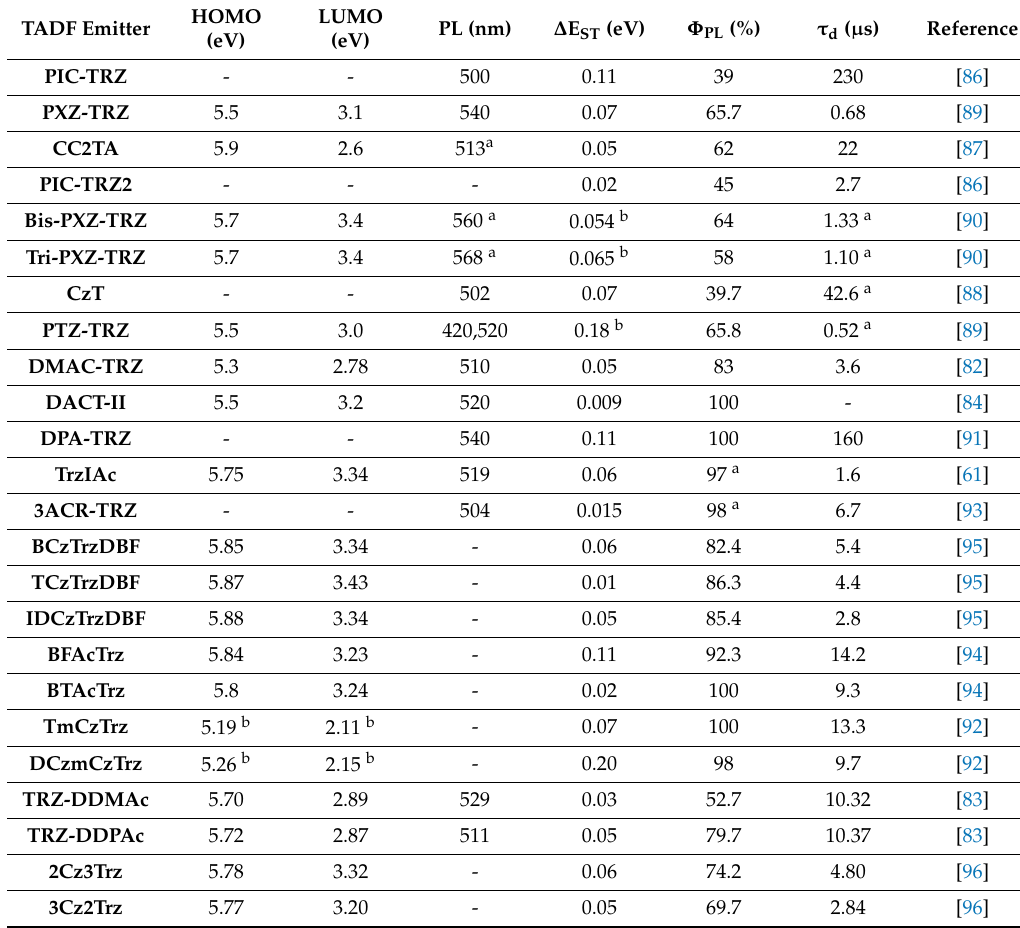
Table 1. Photophysical properties of triazine-based green thermally activated delayed fluorescence (TADF)